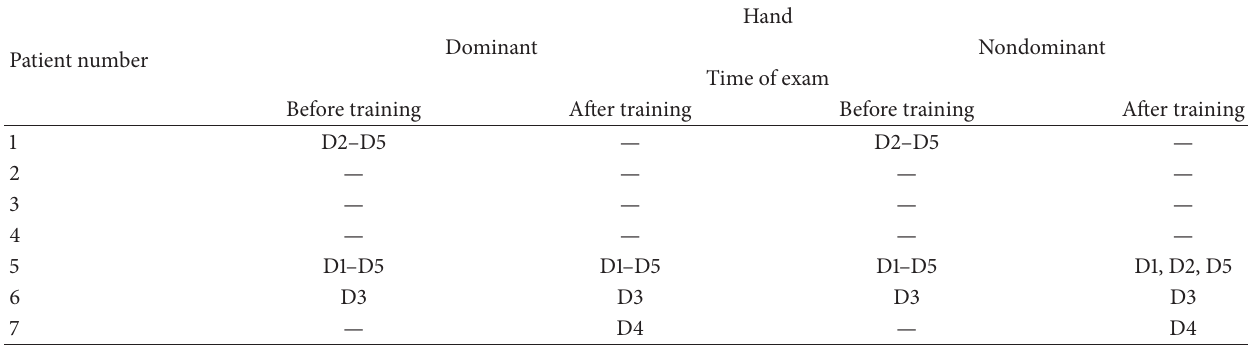
Table 3: Results of the fingers’ calling test. The fingers that were not correctly called are indicated (D1: thumb, D2: index finger, D3: middle finger, D4: ring finger, and D5: little finger).